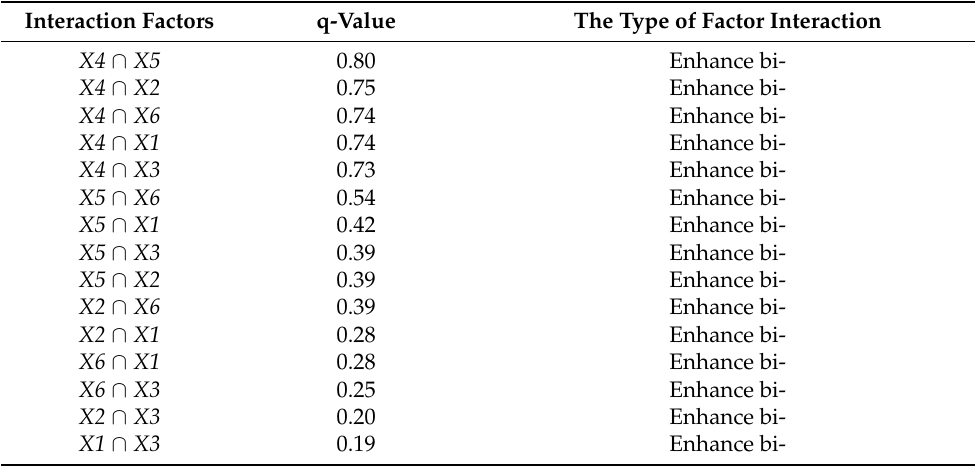
Table 8. Interaction results of different influencing